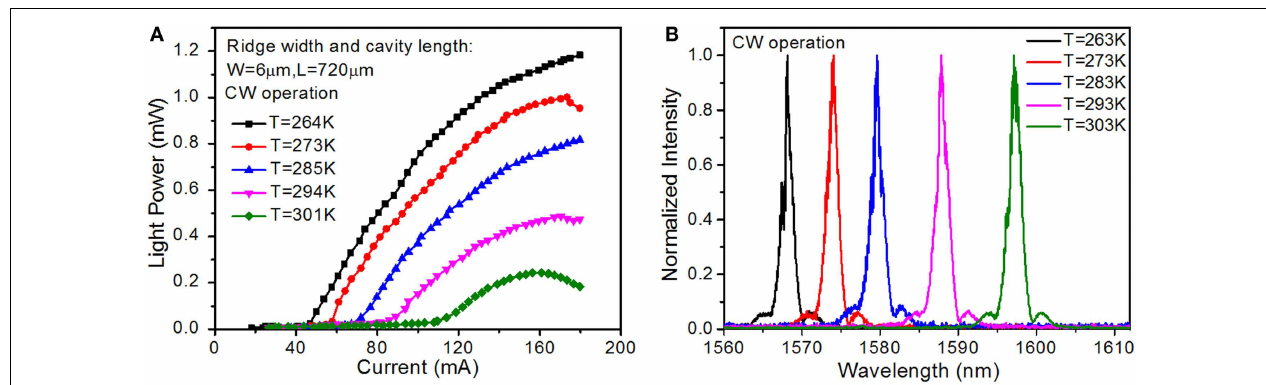
FIGURE 13 | (A) The power–current characteristic curves and (B) the lasing spectra of a typical hybrid silicon FP laser measured under different